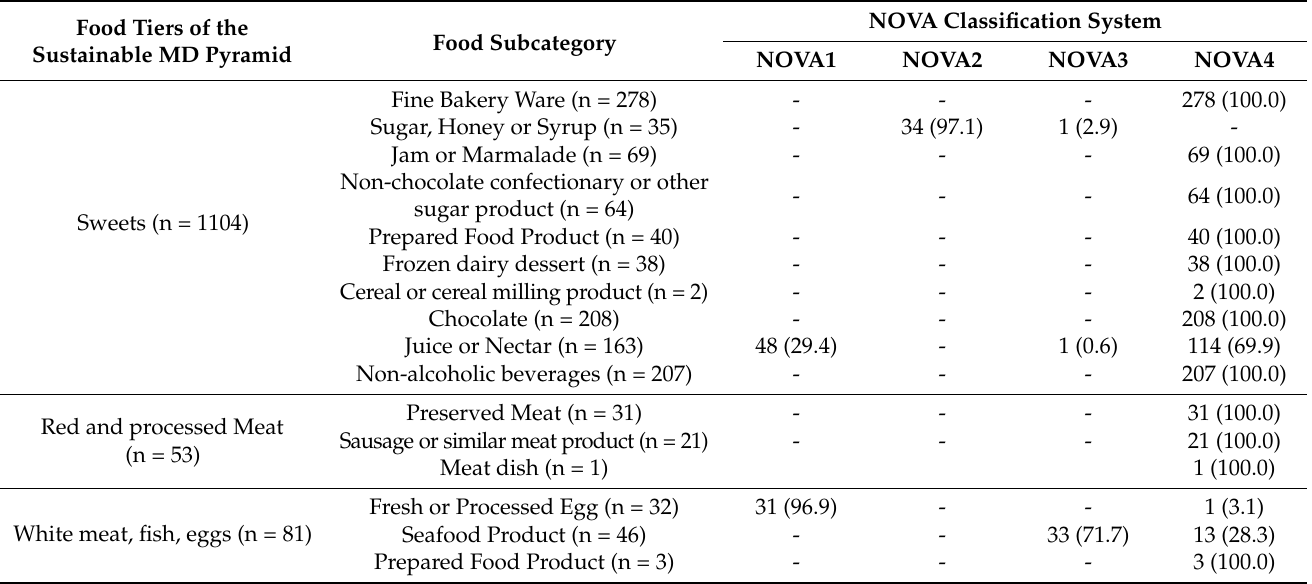
Table 3. Distribution of NOVA Groups among Food Subcategories of the sustainable MD Pyra- mid